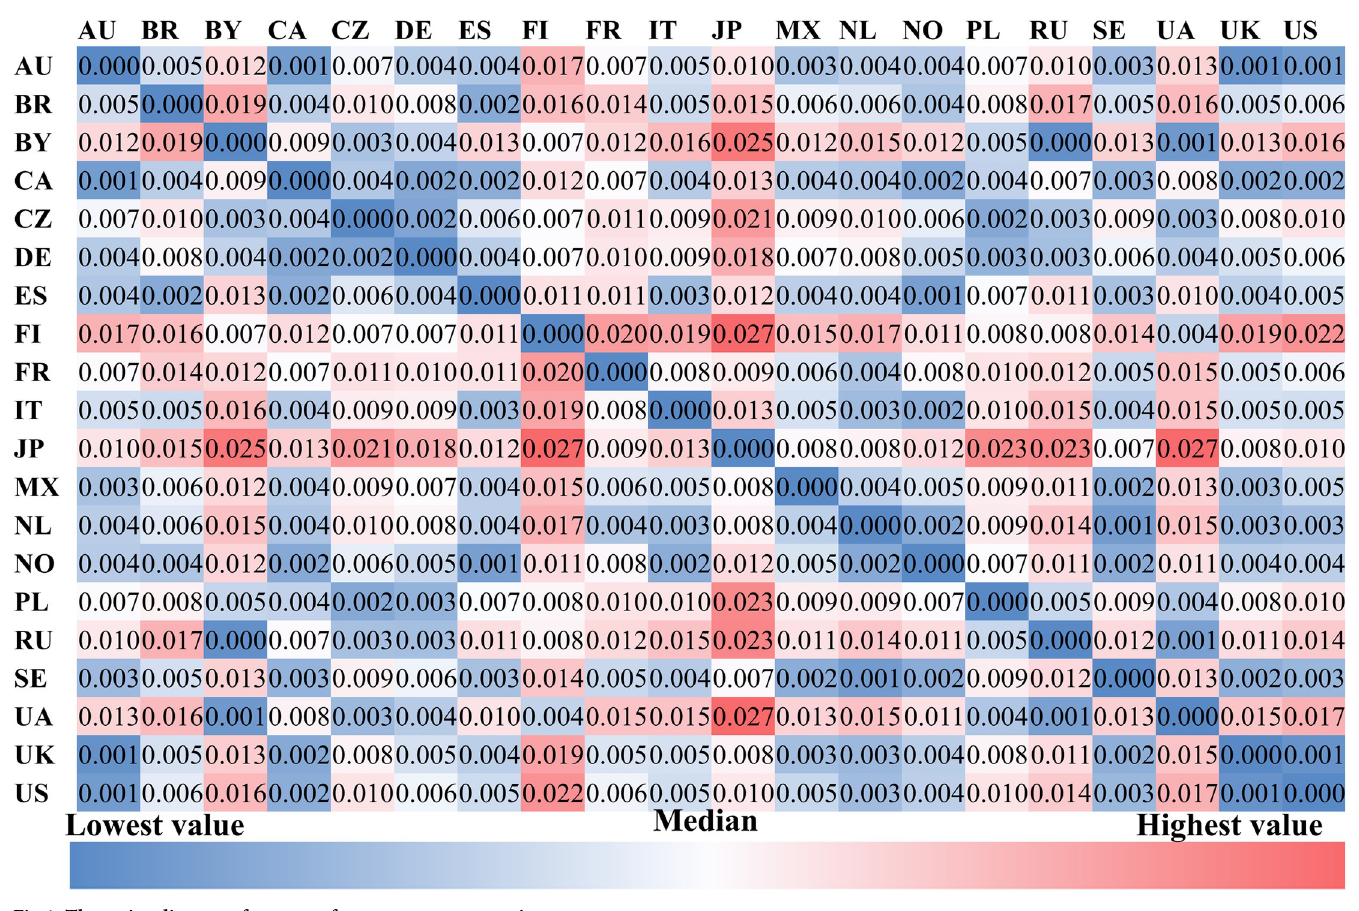
Fig 4. The cosine distance of genre preferences among countries.